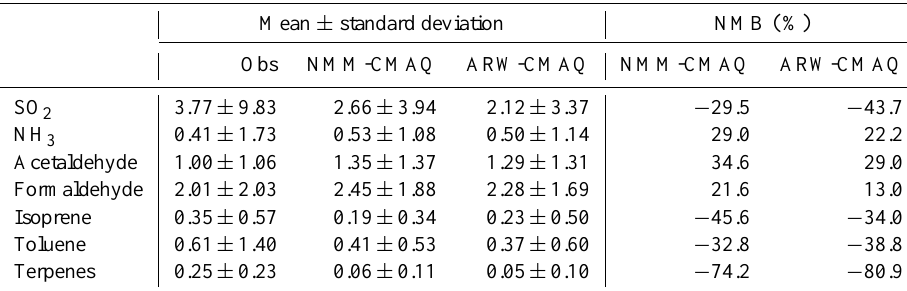
Table 5. Comparison of observations and models (NMM-CMAQ and ARW-CMAQ) for different gaseous species (SO 2 , NH 3 , acetaldehyde, formaldehyde, isoprene, toluene and terpenes) on the basis of all ship measurements over the Gulf of Mexico during the 2006 TexAQS (all units are